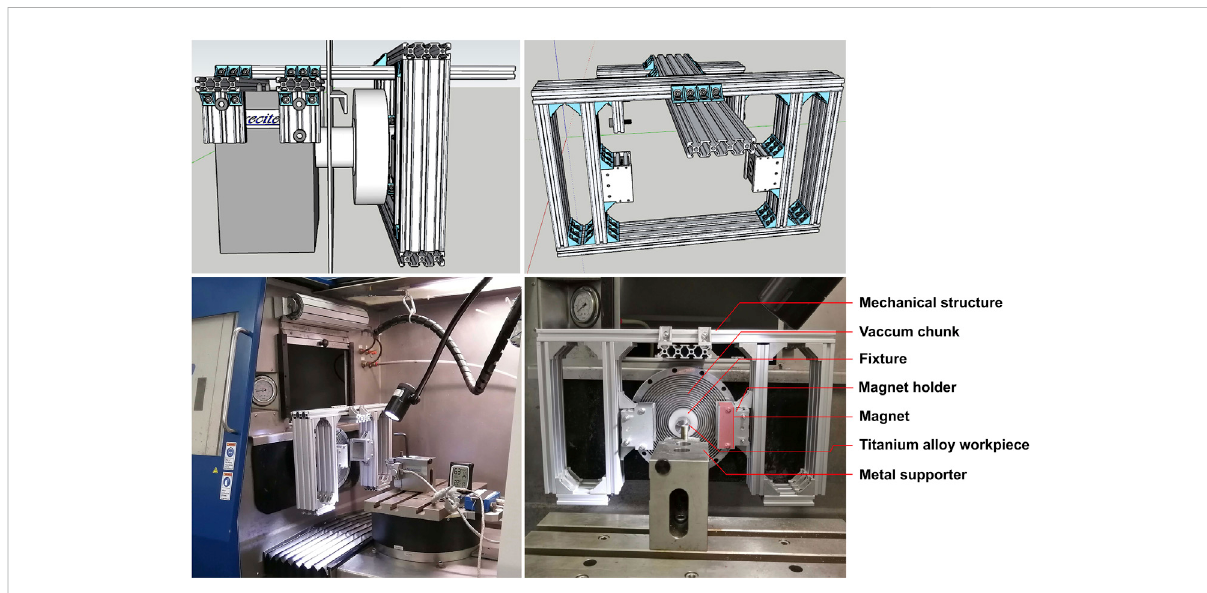
FIGURE 3 3D model of the mechanical structure of the magnetic fi eld assistance technique and the experimental setup of the mechanical structure installed on the Precitech Nanoform 250 Ultragrind machine